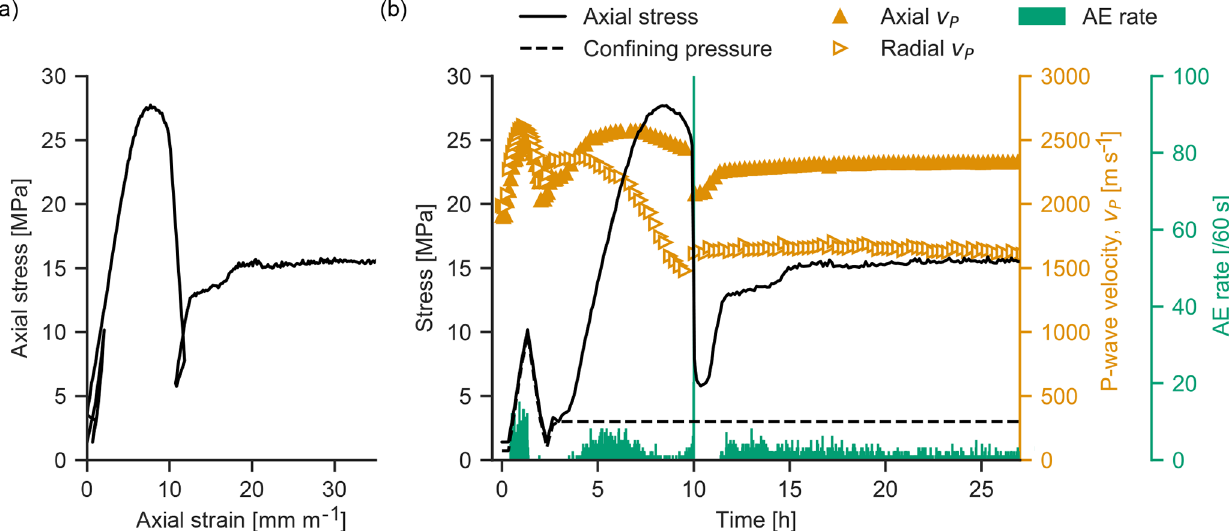
Figure 2. Results of the triaxial testing of dry Red Wildmoor sandstone. (a) Axial strain against axial stress; (b) Axial stress, confining pressure, P-wave velocity in the axial and radial directions, and acoustic emission (AE) rate against time.